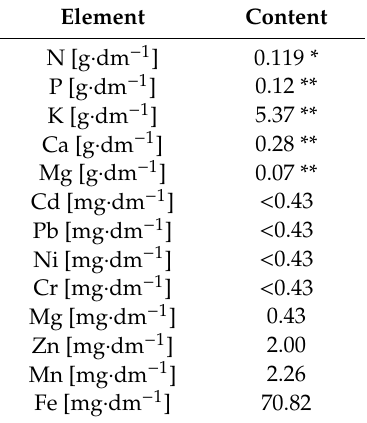
Table 1. Total contents of macronutrients and selected heavy metals in digestate used for cultivating spring rape. Element